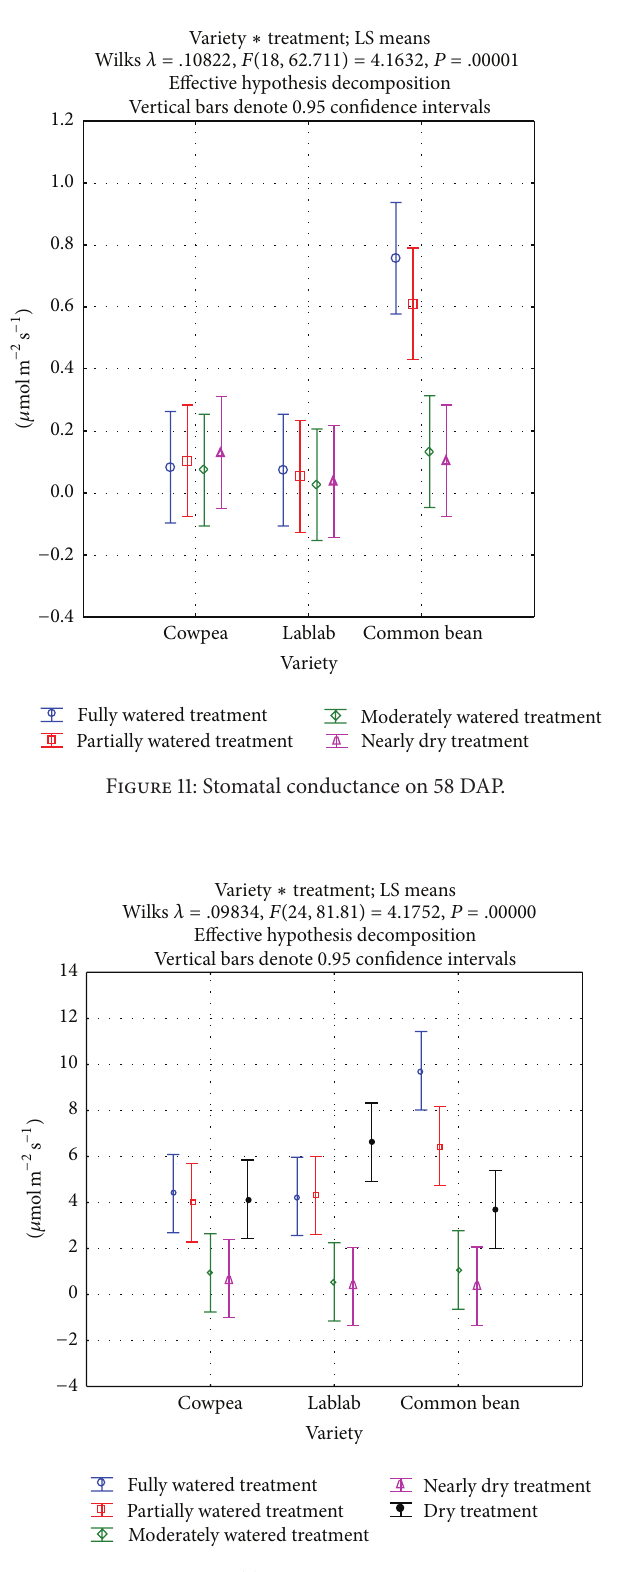
higher transpiration in fully watered condition on 55 DAP, but other treatments showed very little variation. P. vulgaris Figure 12: Transpiration on 55 DAP. had more water use efficiency on 55 DAP. P. vulgaris also showed gradual increase of evaporation rate in different water the gradual increases of transpiration with increasing water regimes on 58 DAP. On 58 DAP, transpiration rate was levels on 55 DAP. L. purpureus and V. unguiculata showed increased after watering in P. vulgaris (Figures 18 and